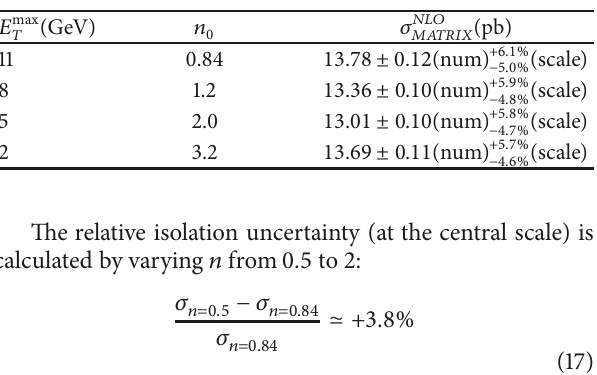
Table 2: The “central values” of the parameter 𝑛 = 𝑛 0 .